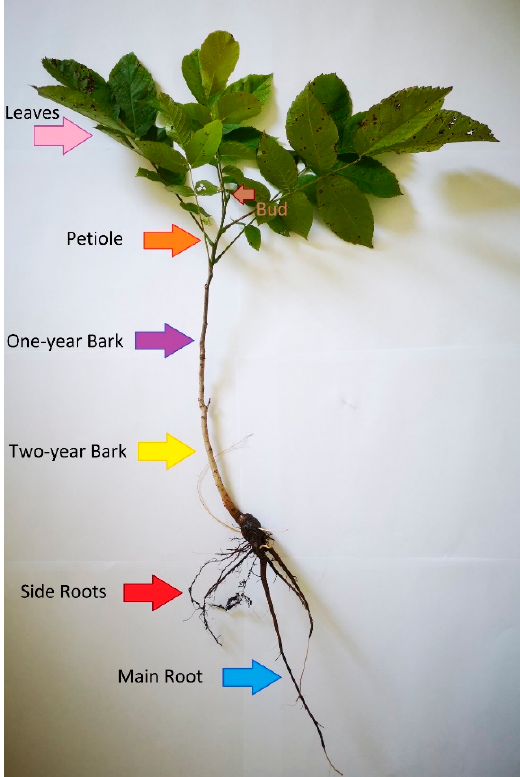
Figure 1. The different tissues of the 2-year-old walnut plants included in the